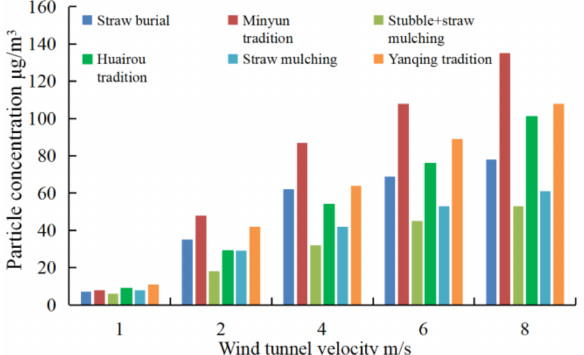
Figure 21. Changes of PM2.5 concentrations at 10 cm height under different wind speeds.